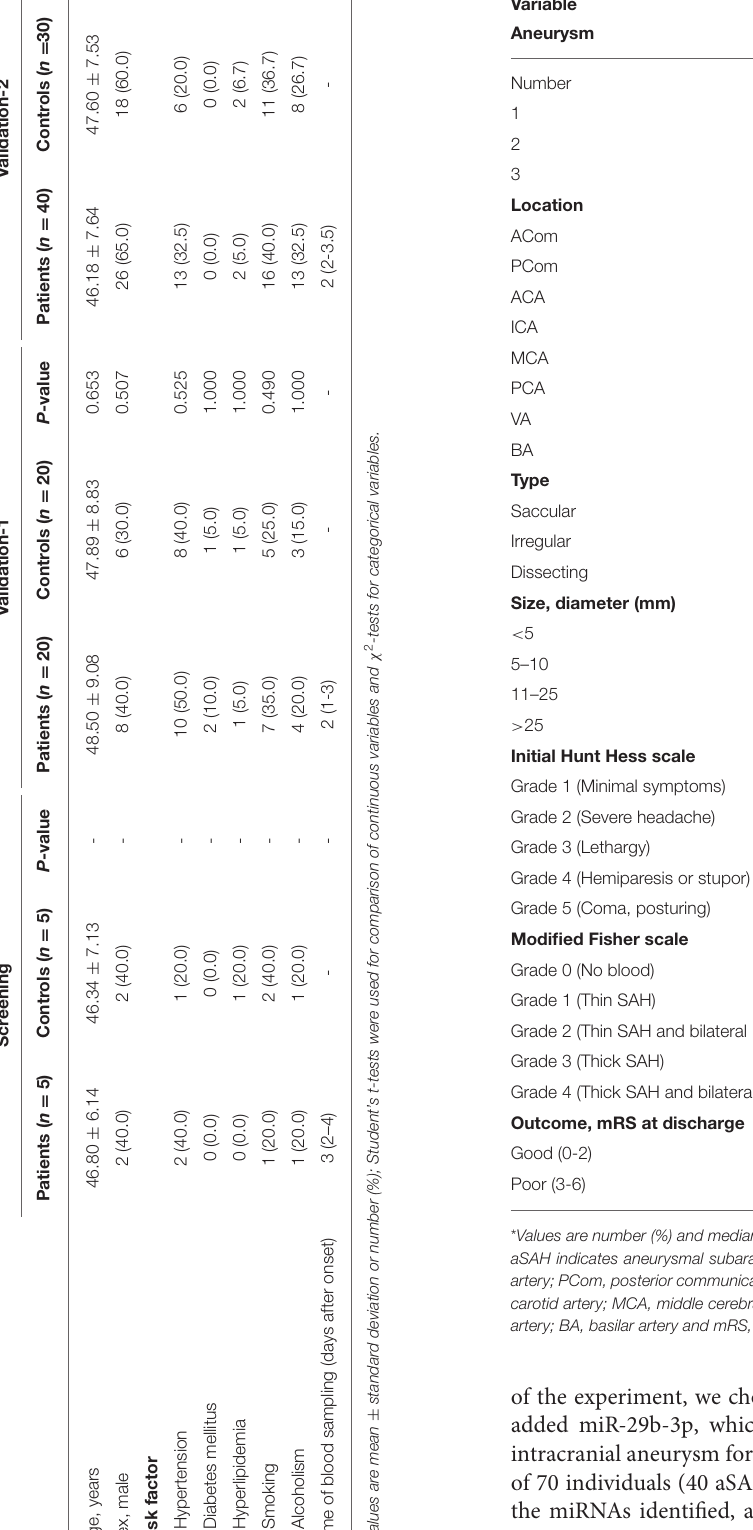
TABLE 2 | Radiologic and clinical features of patients with aneurysmal subarachnoid hemorrhage*. Variable aSAH patients ( n =